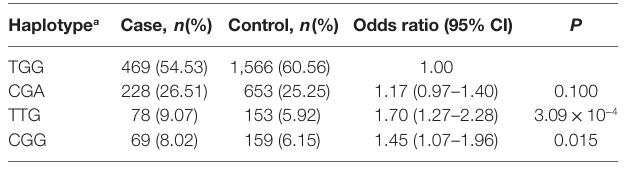
TaBle 4 | Associations between three-site haplotypes in the cytochrome P450 family 17 subfamily A member 1 gene region and type 2 diabetes mellitus risk in Han Chinese participants.